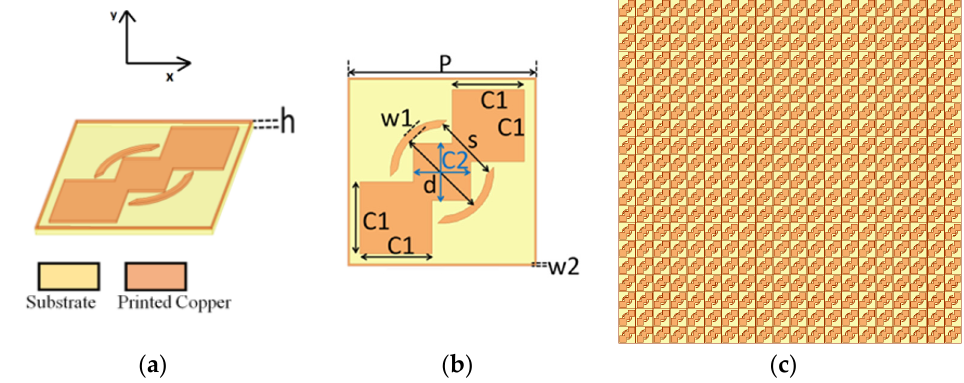
Figure 1. Unit cell for the proposed structure: ( a ) perspective 3D view; ( b ) top view; ( c ) 2D array.